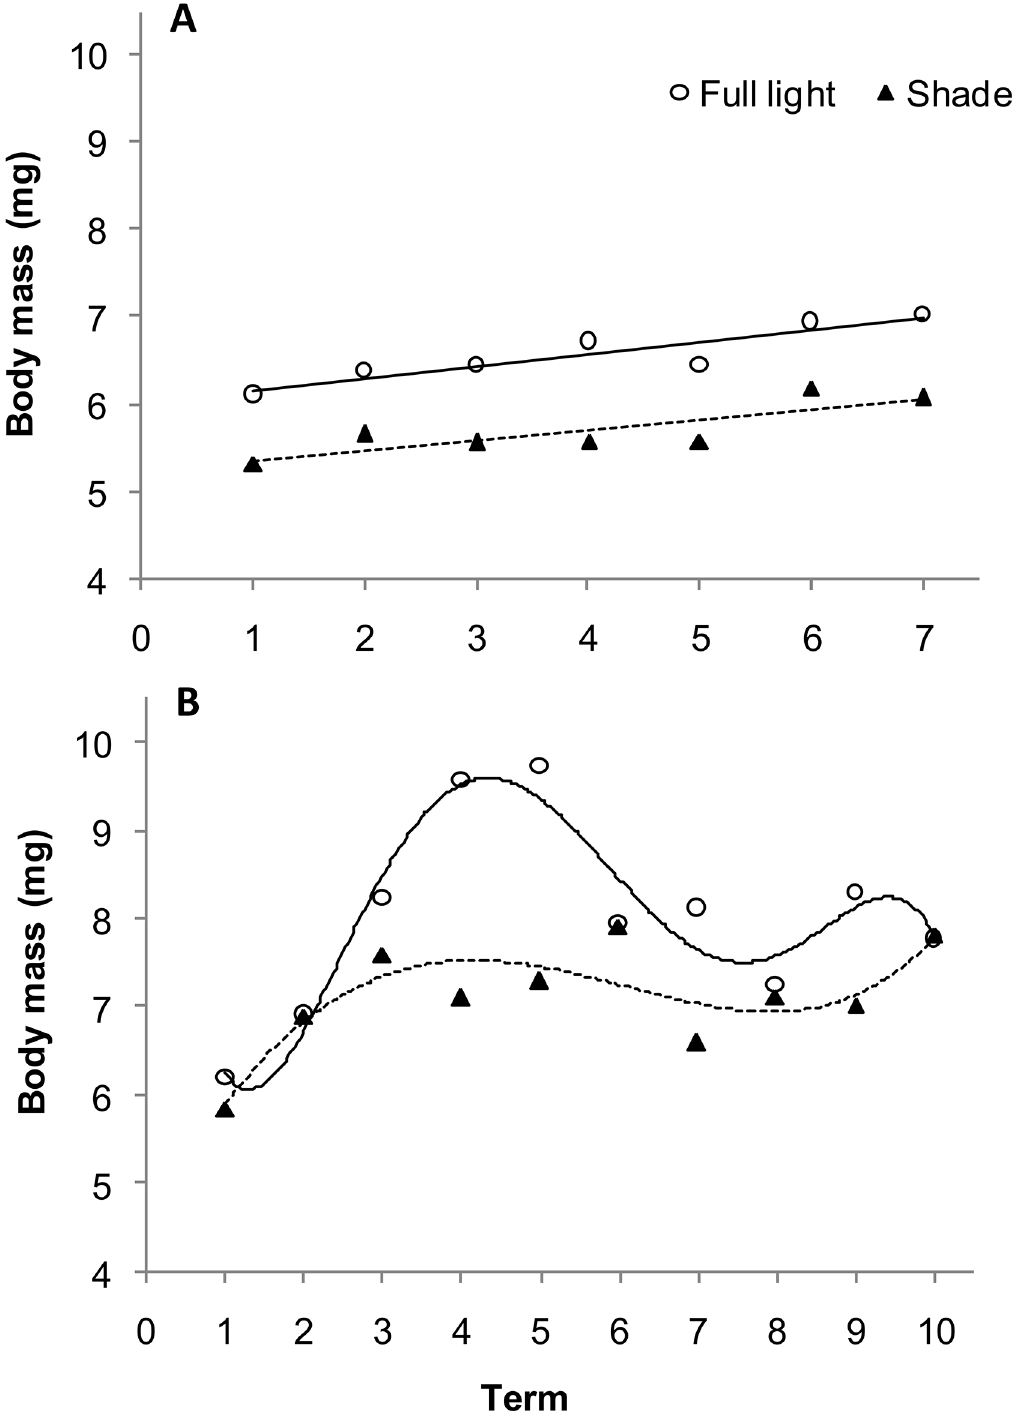
Fig 5. Body mass of current-year (A) and 1-year-old (B) Altica brevicollis coryletorum beetles on shrubs growing in full light and shaded conditions over time. Numbers 1 – 7 (for current-year beetles) and 1 – 10 (for 1-year-old beetles) indicate successive dates of insect collection (see Materials and Methods). One-way ANOVA was used to determine the effect of term (length of the sampling period) on current-year beetles (full light, R 2 = 0.0515, P < 0.0001; shade, R 2 = 0.0576, P = 0.0002) and on 1-year-old beetles (full light, R 2 = 0.1742, P < 0.0001; shade, R 2 = 0.0616, P <